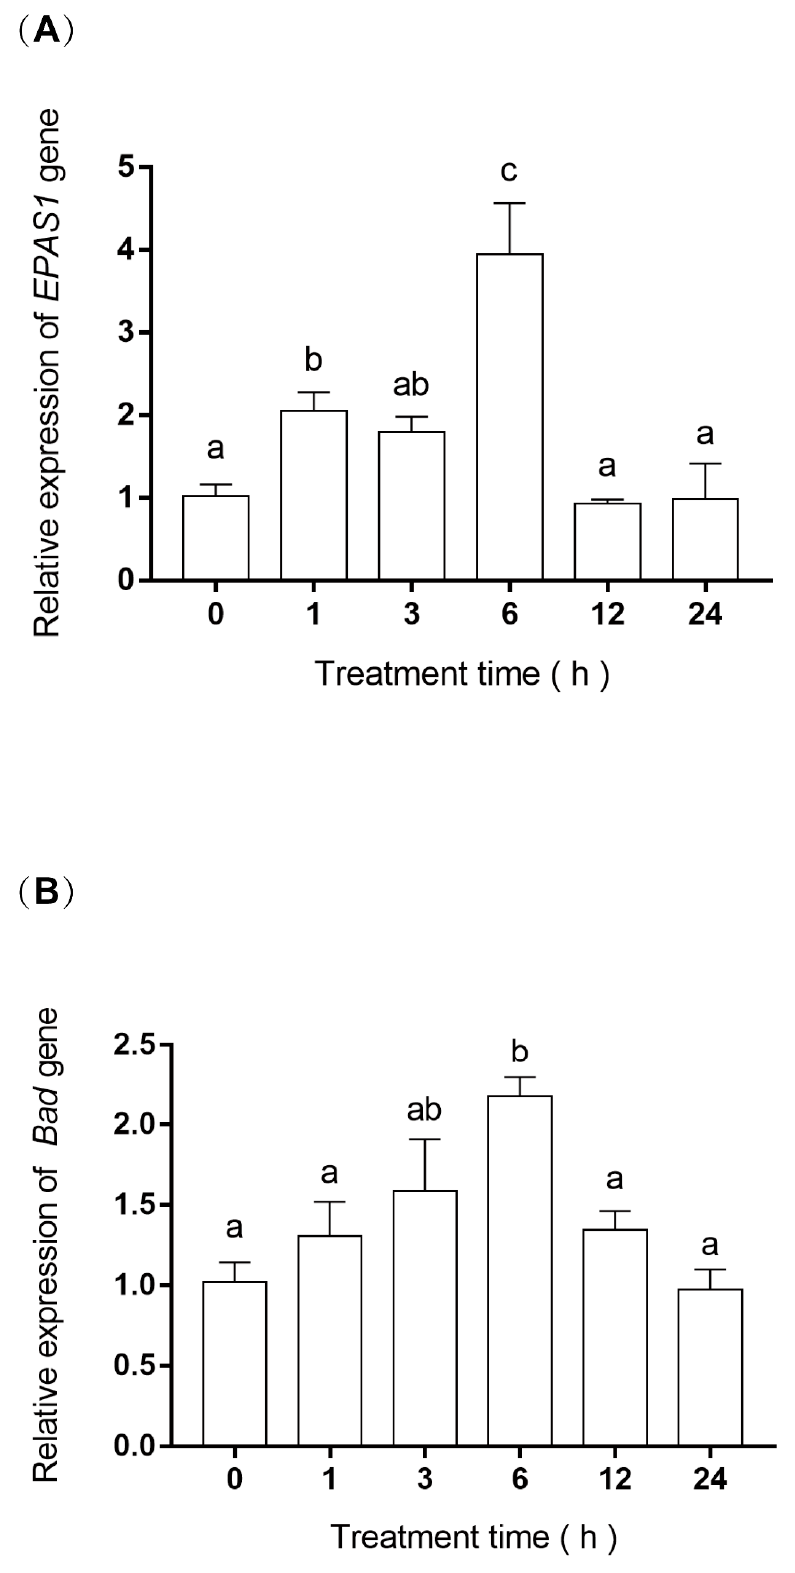
Figure 4. ( A ) The mRNA relative expression of EPAS1 in gill. ( B ) The mRNA relative expression of Bad in gills. Significance was set at p < 0.05, and significant post hoc differences between time exposure are shown by uncommon